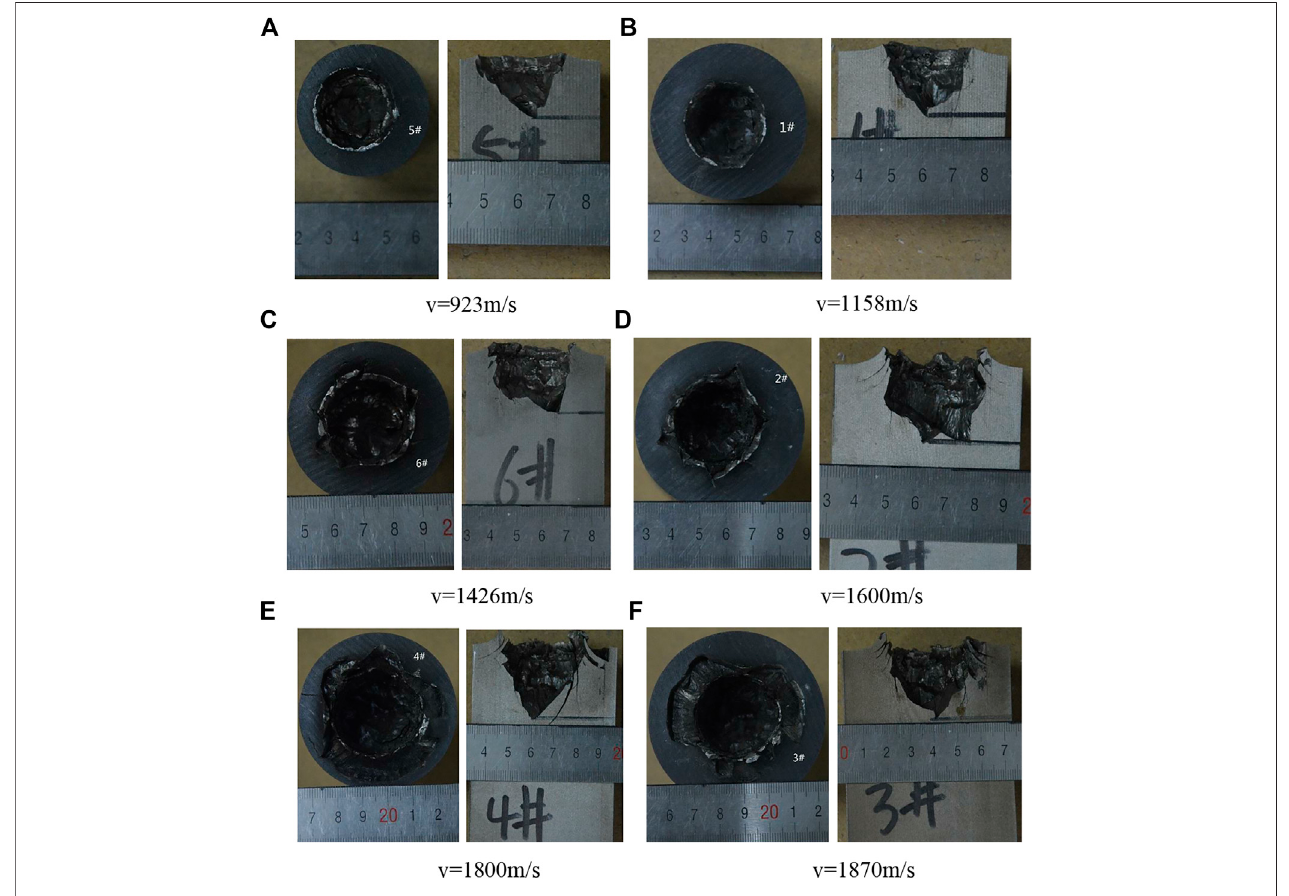
FIGURE 5 | Photographs of cross sections of G50 steel target after impact by a tungsten alloy spherical fragment. (A) v (cid:1) 923 m/s (B) v (cid:1) 1,158 m/s (C) v (cid:1) 1,426 m/s (D) v (cid:1) 1,600 m/s (E) v (cid:1) 1,800 m/s, and (F) v (cid:1) 1,870 m/s.